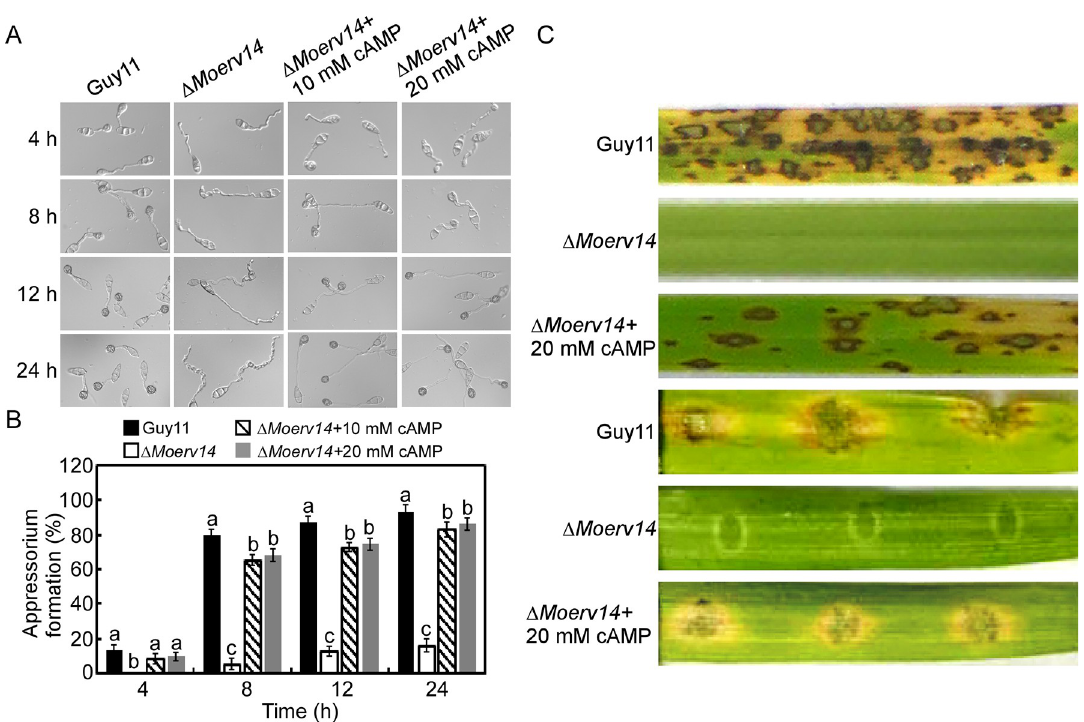
Fig 4. MoErv14 is important for the appressorium formation and virulence by regulating cAMP level in M . oryzae . (A) Exogenous cAMP suppressed the appressorium formation defect of the Δ Moerv14 mutant. (B) Statistical analysis of the appressorium formation rate. Error bars represent ± standard deviations (SD), and different numbers denote statistical significances ( p < 0.01). (C) Two-week- old rice seedlings ( Oryza sativa cv. CO-39) were sprayed with tested with a conidial suspension of different mutants (5 × 10 4 conidia/ml). The diseased leaves were harvested and photographed 7 days after inoculation. Three independent experiments were performed. Separated barley leaves were dropped with serial dilution (5 × 10 4 conidia /ml) of conidial suspensions, and diseased leaves were photographed 5 days after